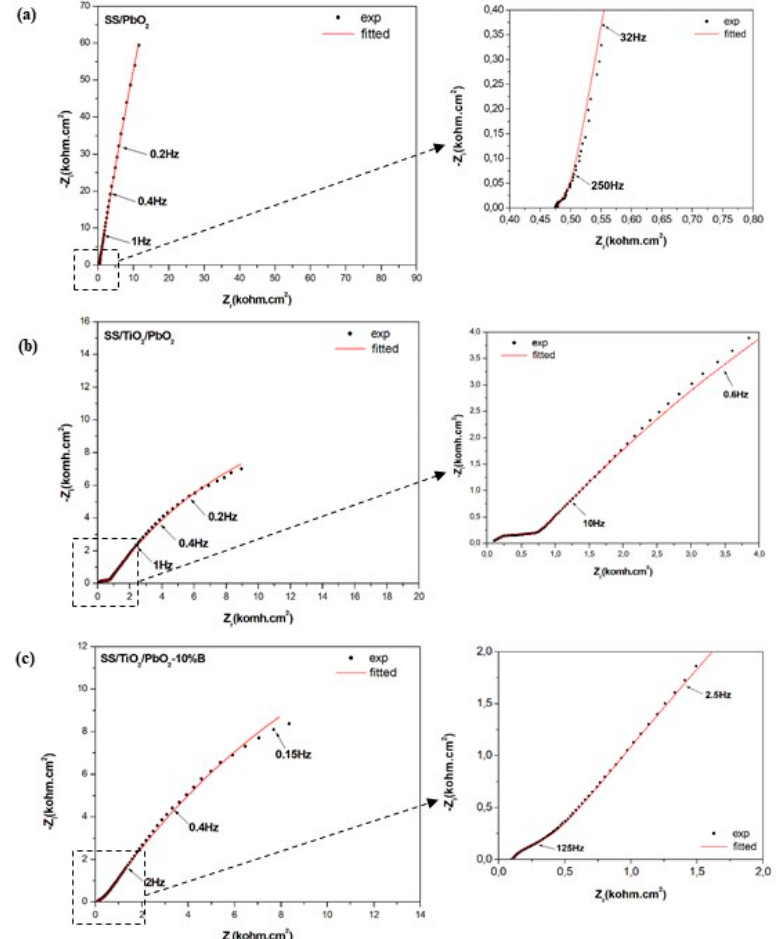
Figure 8. Nyquist impedance plots of ( a ) SS/PbO 2 , ( b ) SS/TiO 2 /PbO 2 and ( c ) SS/TiO 2 /PbO 2 -10%B anodes in 0.1 M Na 2 SO 4 solution.